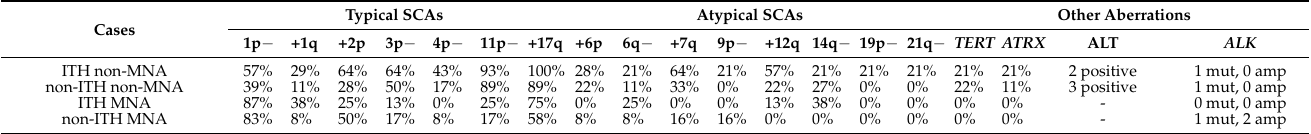
Table 3. Percentage of the analysed cases with or without intratumor heterogeneity (ITH, and non-ITH, respectively) and without or with MYCN amplification (non-MNA and MNA, respectively) that showed typical segmental chromosomal aberrations (SCAs), the most frequently found atypical SCAs, and other genomic aberrations as focal SCAs in TERT and ATRX genes, number of cases with presence of alternative lengthening of telomeres (ALT positive), and presence of mutations (mut) or amplification (amp) in ALK